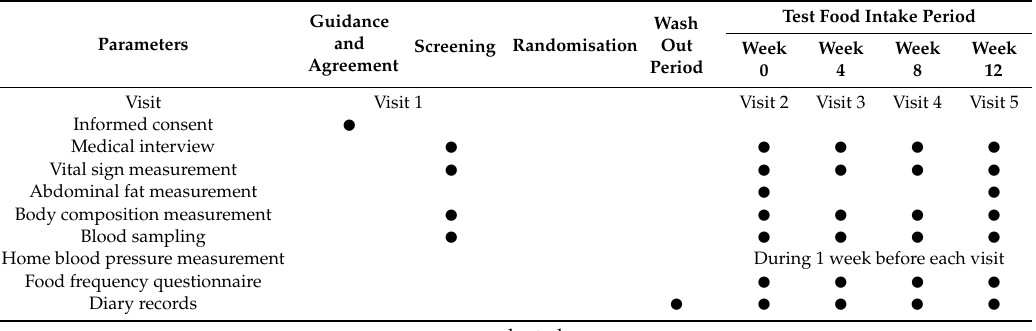
Table 1. Clinical trial